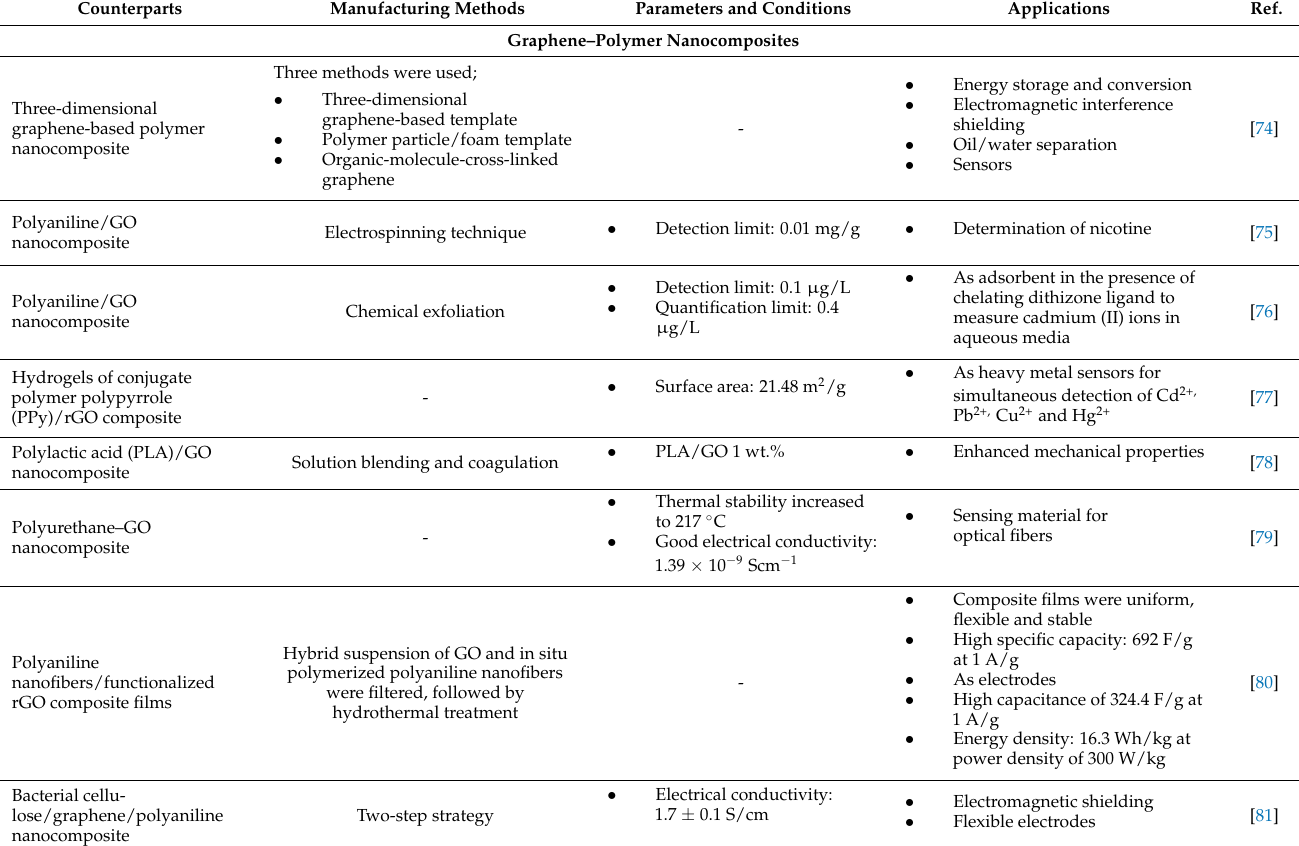
Table 1. Summary of the graphene nanocomposites with inorganic and polymeric